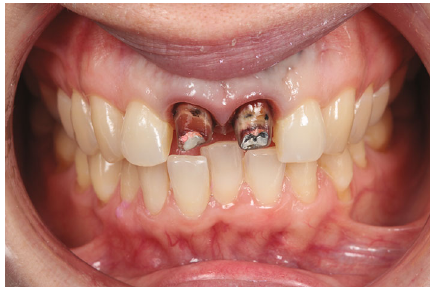
Figure 25: Frontal view of the stump of 1.1 and 2.1 based on the BOPT